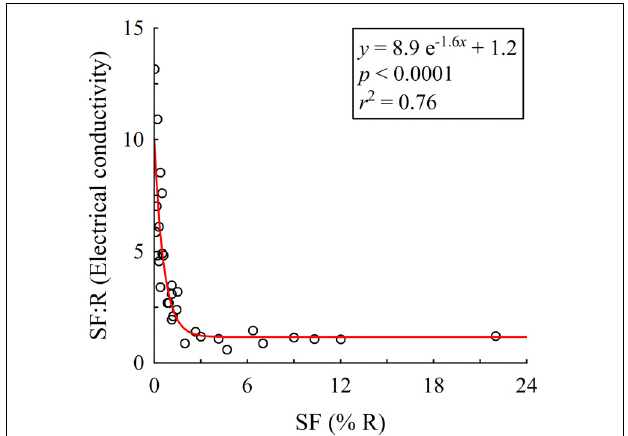
FIGURE 2 | The ratio of stemflow (SF) to rainfall (R) electrical conductivity for selected studies that represent a wide range of SF values as a percentage of rainfall amount. Studies associated with each data point are provided in Supplementary Table